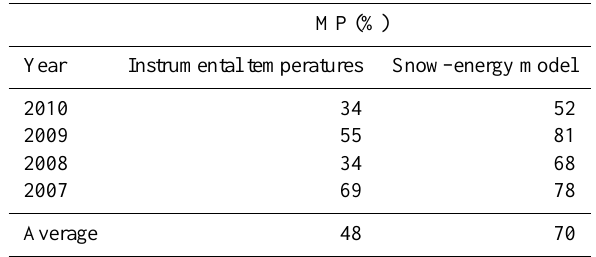
Table 5. Percentages of melted annual snow accumulation (MP) calculated with the PDD approach (Pohjola et al., 2002; Nuth et al., 2012) using instrumental temperatures, and the snow–energy model (van Pelt et al.,